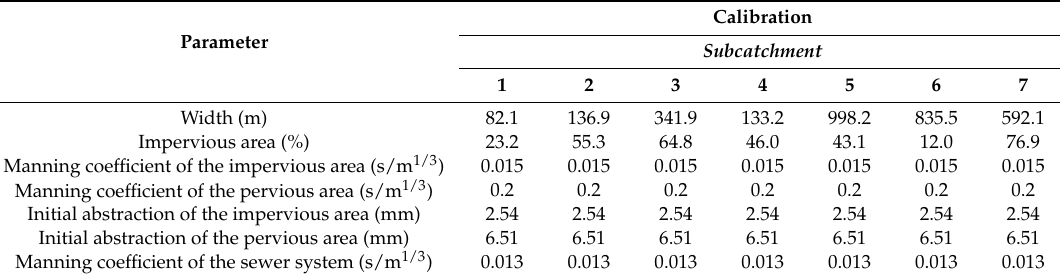
Table 1. Calibrated parameters for the SWMM